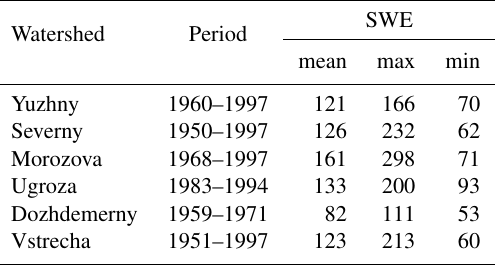
Figure 12. Snow evaporation (mm) during the day and night peri- ods, 1976–1977.